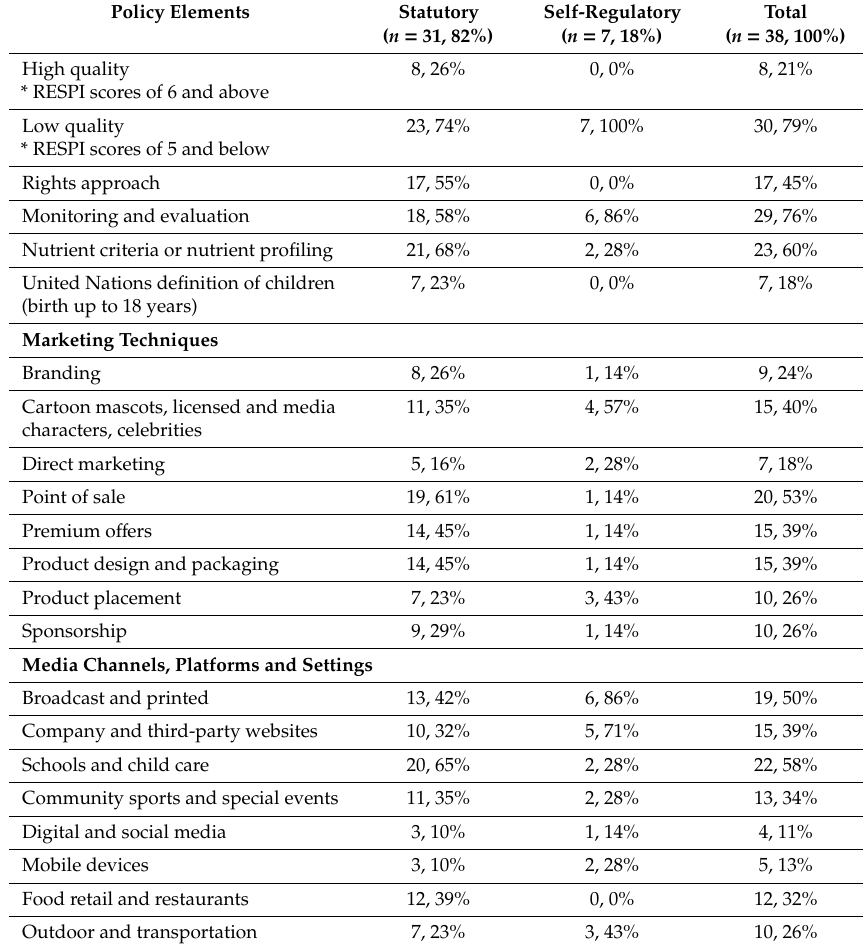
Table 4. Comparison of statutory and self-regulated policies that restrict the marketing of HFSS food and beverage products to children of 14 countries in the Americas Region